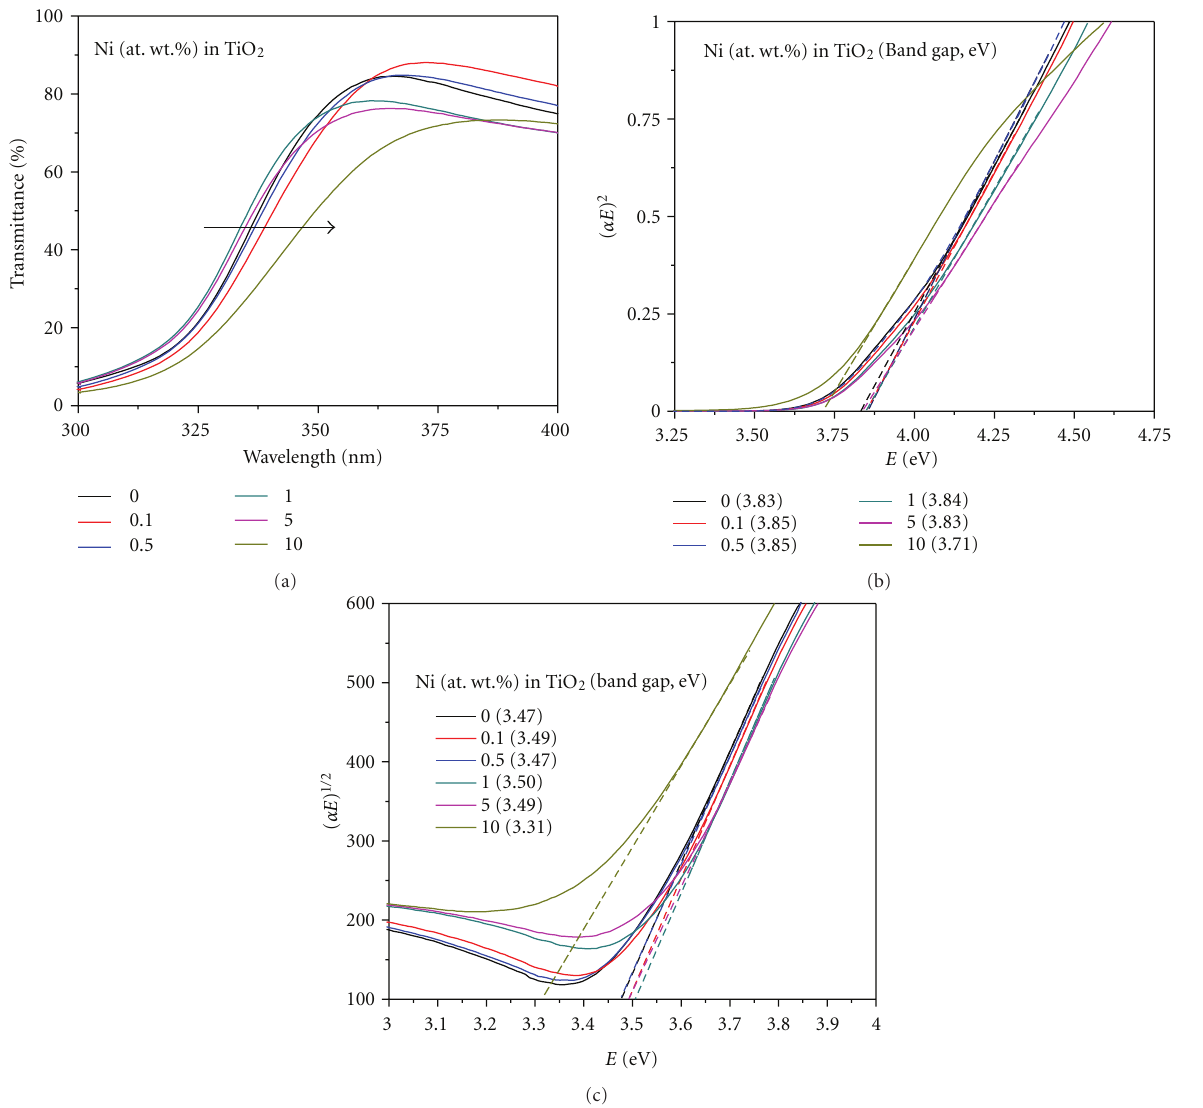
Figure 14: (a) UV-vis transmittance spectra of Ni-doped TiO 2 (Ni = 0, 0.1, 0.5, 1, 5, and 10 at. wt.%) thin films formed 600 ◦ C for 30 min, and their corresponding transformed spectra showing direct bandgap (b) and indirect bandgap (c) values.